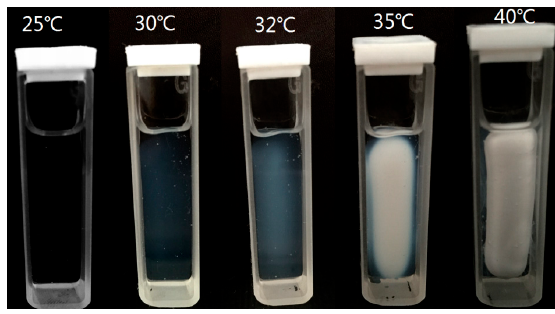
Figure 4. Photograph of IPN hydrogel (IPN-3) at different temperatures.